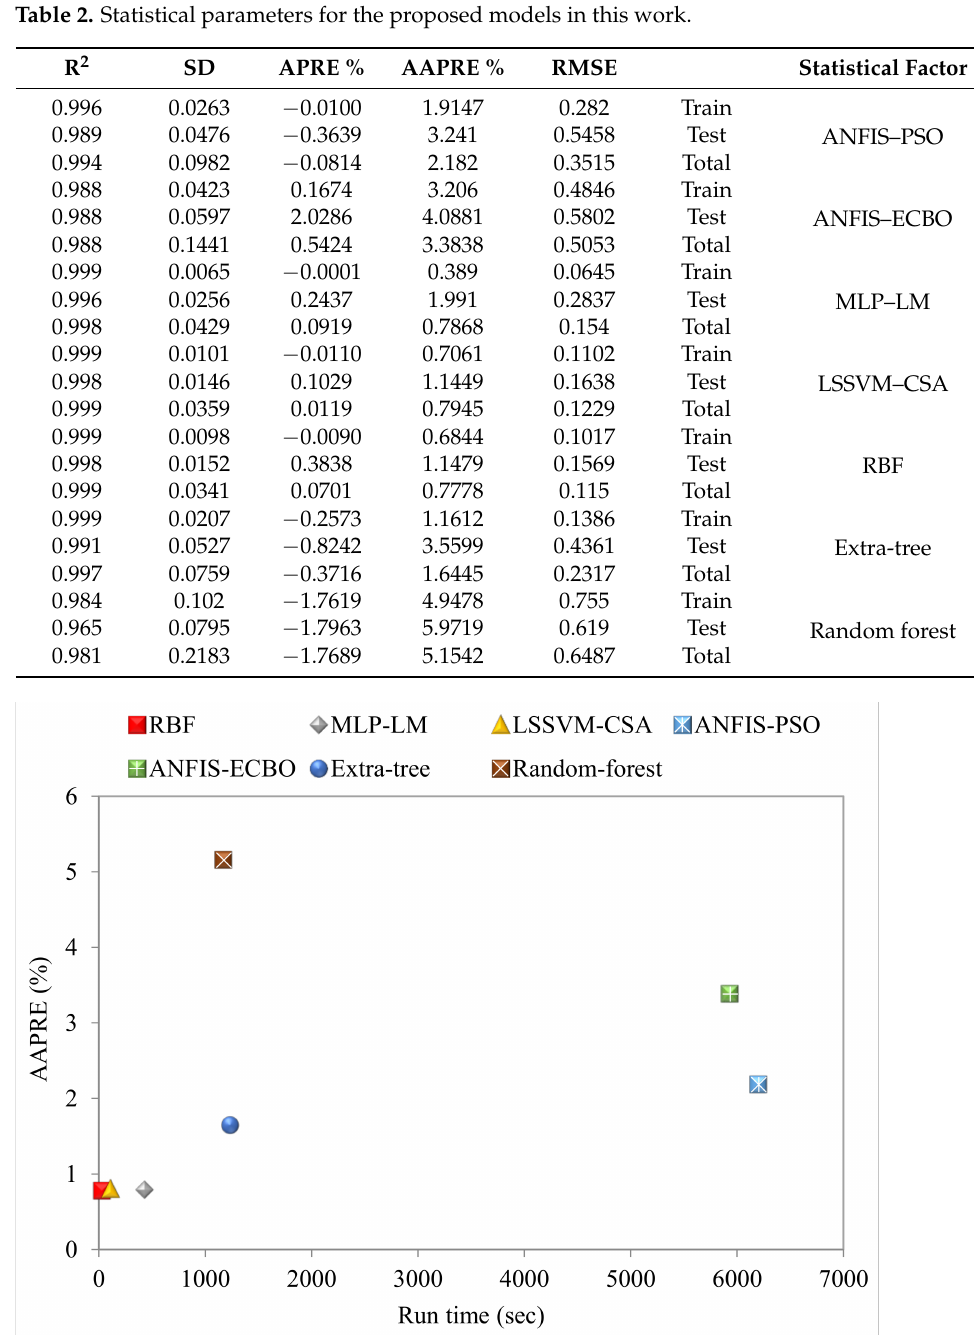
Figure 5. The run time and computational accuracy for various methods.